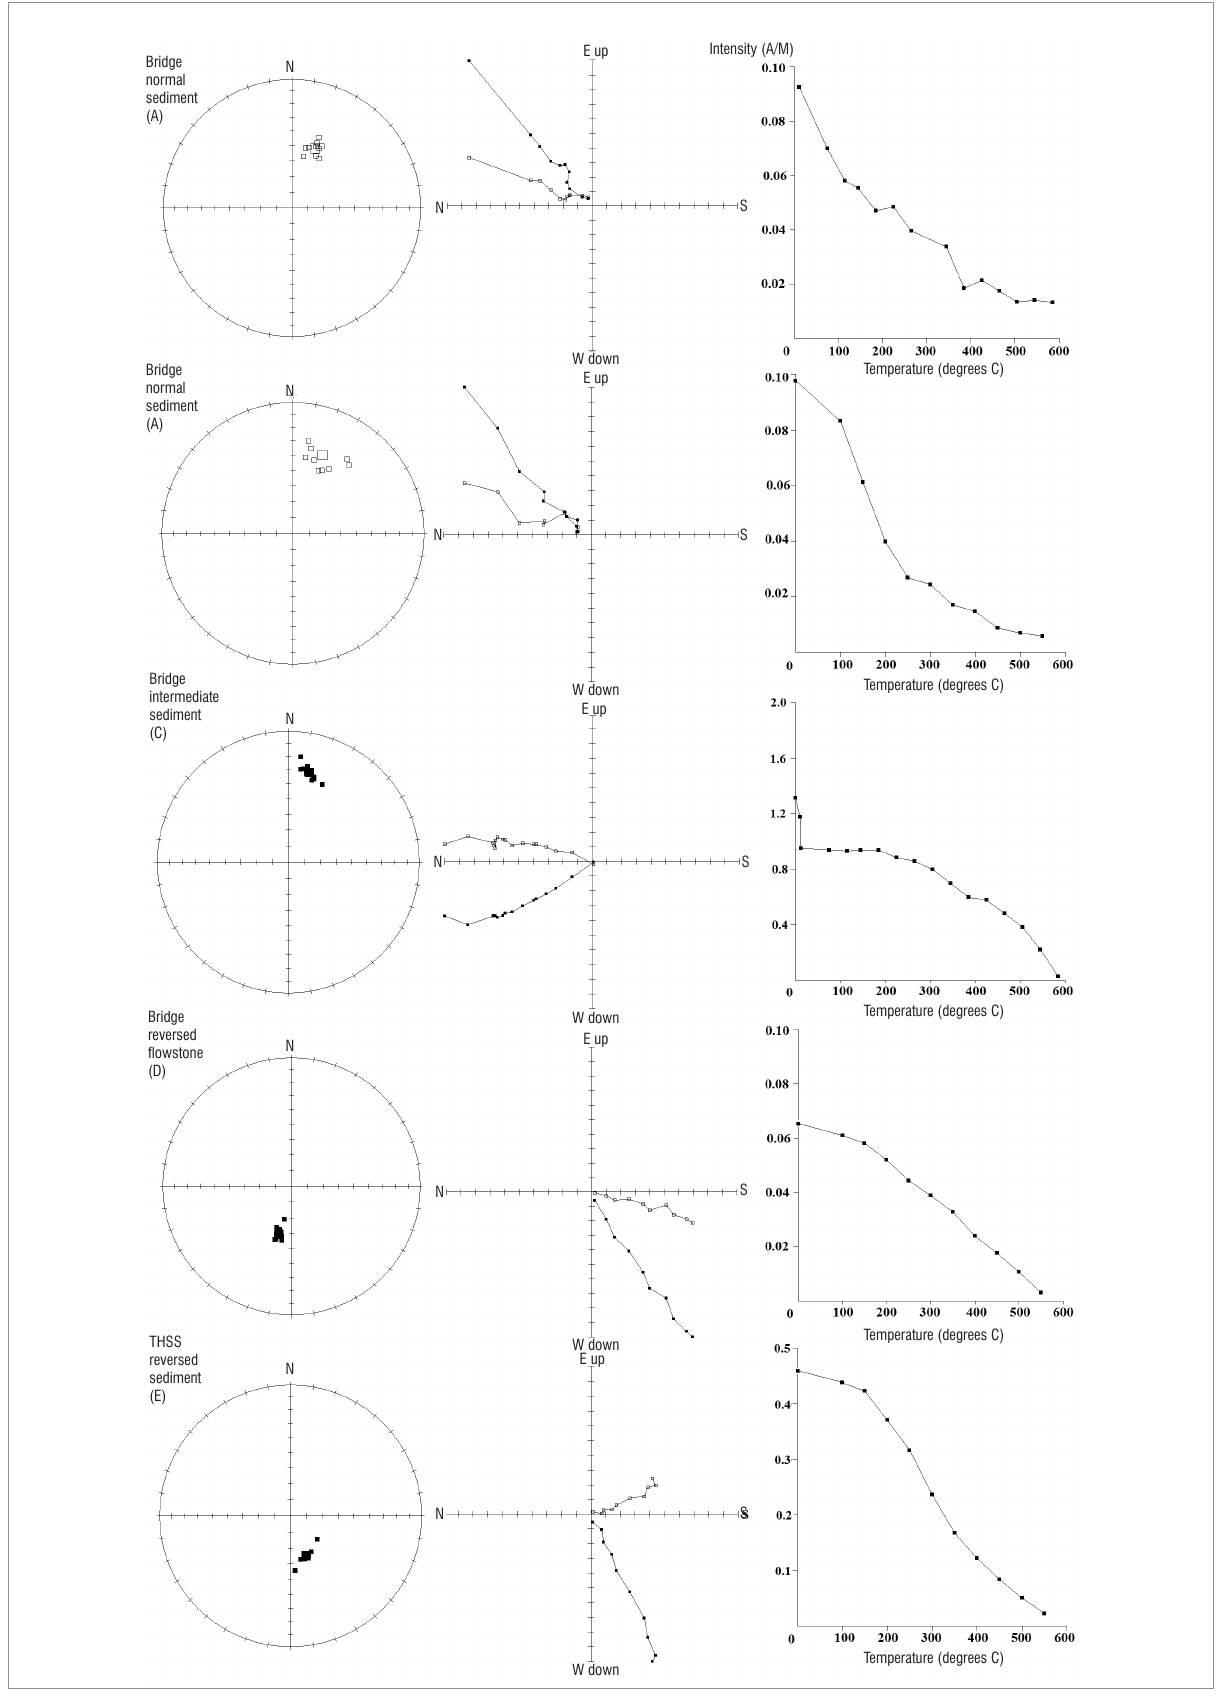
Figure 8: Demagnetisation spectra (stereo, Zijderveld and intensity plots) for representative (a,b) normal, (c) intermediate and (d,e) reversed polarity siltstone within (a–c) breccia, (e) mudstone and (d) flowstone samples from